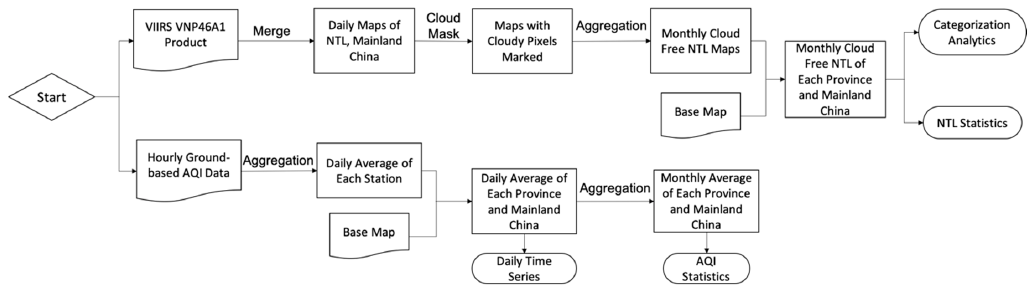
Figure 1. Workflow of the analytical process.